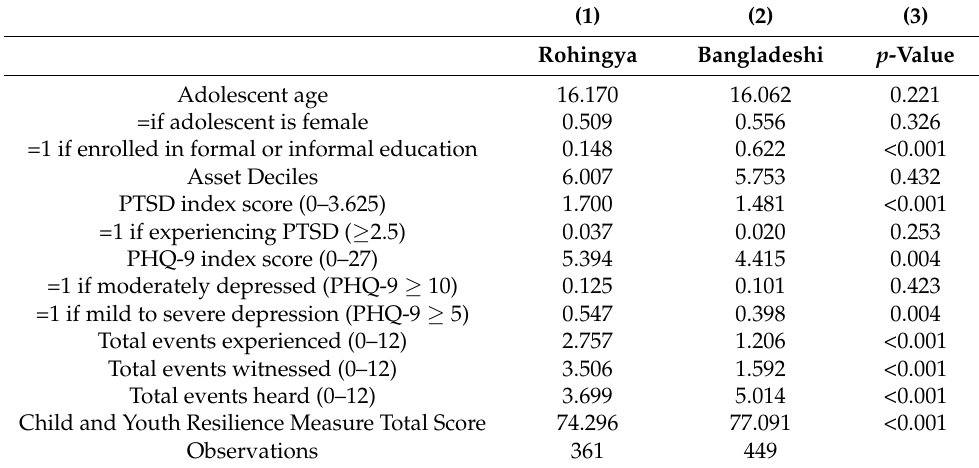
Table 1. Descriptive statistics, Rohingya refugee and Bangladeshi adolescents aged